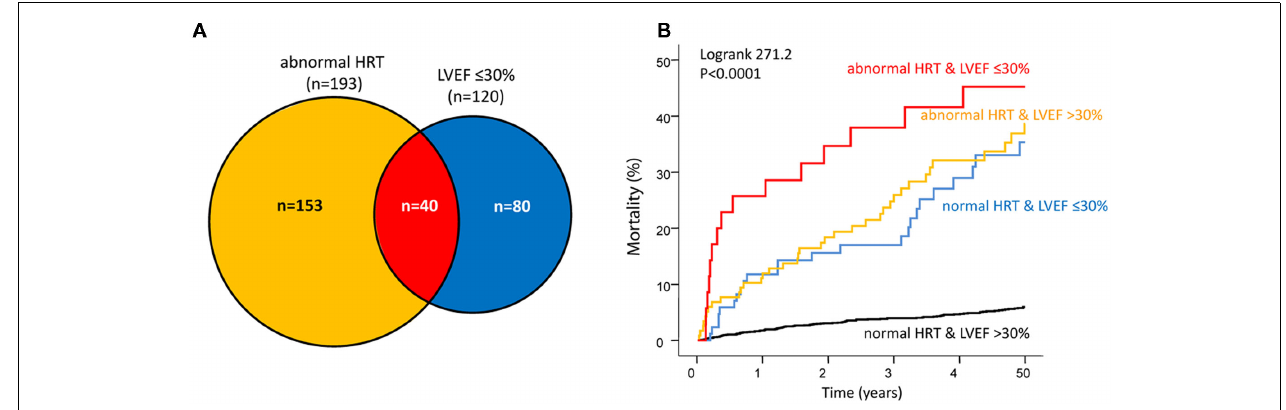
FIGURE 3 | Complimentary risk stratification by HRT and LVEF in the ISAR-RISK study (Bauer et al., 2009a). (A) Distribution of patients with abnormal HRT but LVEF > 30% ( n = 153, orange area), abnormal HRT and LVEF ≤ 30% ( n = 40, red area), and normal HRT but LVEF ≤ 30% ( n = 80, blue area). (B) Corresponding 5-year mortality rates of the three groups. Abnormal HRT defined as HRT category 2 (adapted by permission from Bauer et al.,